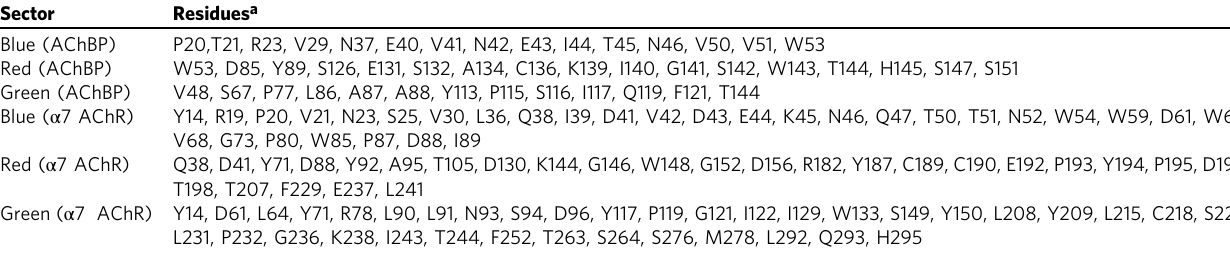
Table 2 Sector residues identi fi ed in the AChBP and α 7-based statistical coupling analyses.